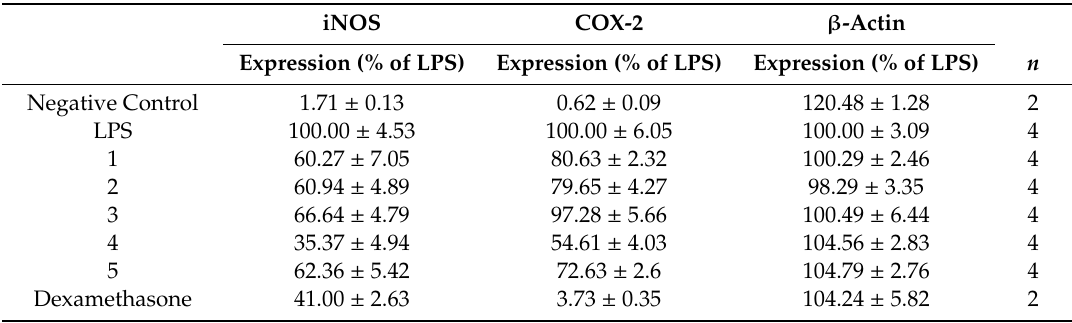
Table 3. E ff ects of briaranes 1 – 5 on LPS-induced pro-inflammatory iNOS and COX-2 protein expression in macrophages.